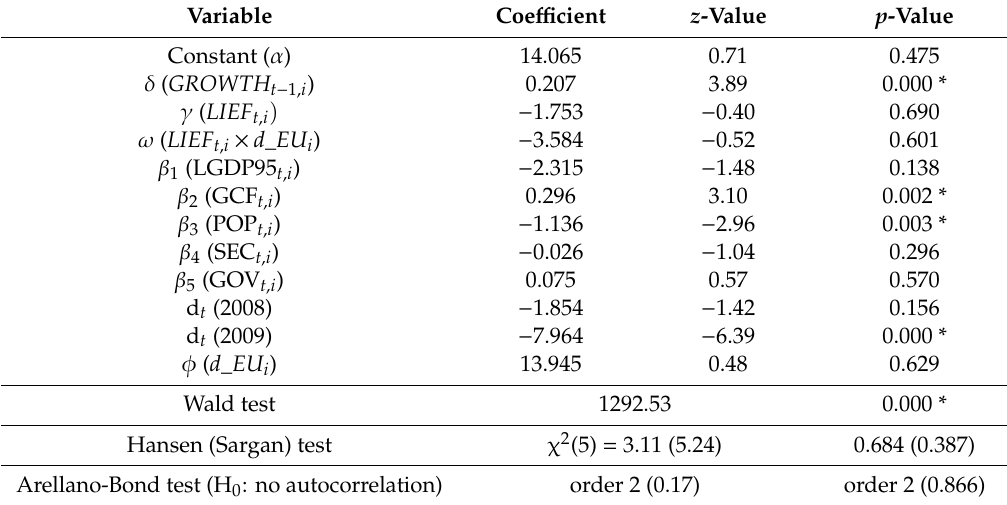
Table 9. Results from the System GMM model with logarithm of economic freedom